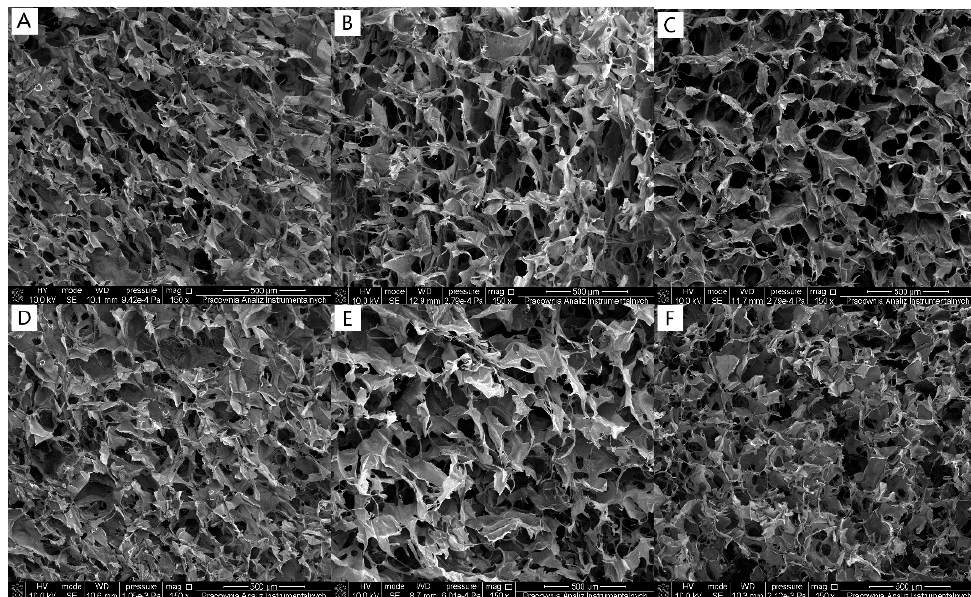
Figure 1. SEM images of 80CTS/20Coll ( A ), 80CTS/20Coll+5%G ( B ), 50CTS/50Coll ( C ), 50CTS/50Coll+5%G ( D ), 20CTS/80Coll ( E ), and 20CTS/80Coll+5%G ( F ) (magnification: 150×).